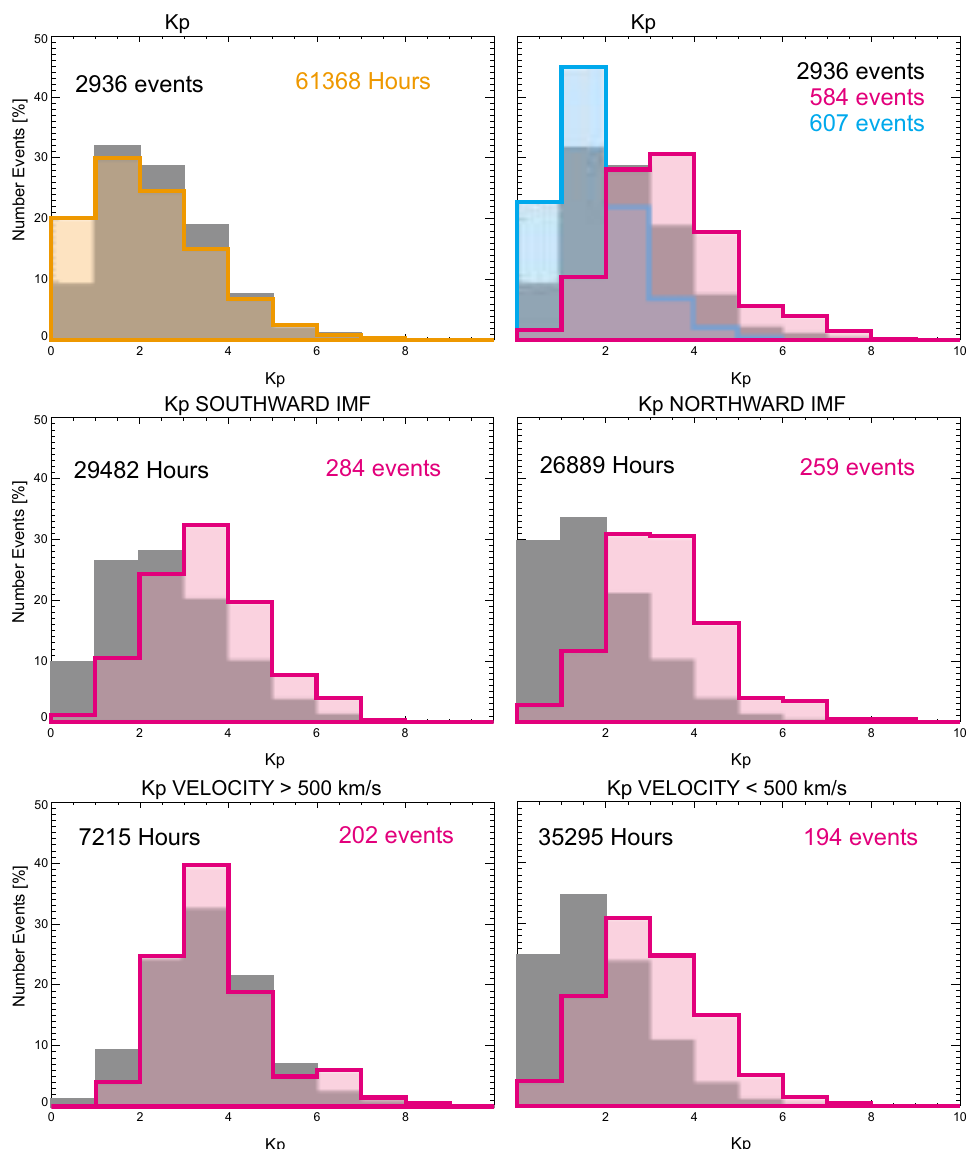
Fig. 14. Relative occurrences as functions of K p at the time of events are displayed. In the top two panels, the gray block diagrams present the distributions for all events. In the top left panel is shown also (orange curve and shading) the background distribution for the entire period covered in the analysis (61368h). The panel at the top right displays the separate distributions for the large (magenta) and small (cyan) amplitude subgroups of events. The middle panels display the background distributions (gray block-diagrams) as well as the large amplitude events (magenta curves and shading) for southward (left panel) and northward (right panel) IMF conditions, respectively. Similarly, the bottom panels show the separate distributions for solar wind speeds larger (left panel) and smaller (right panel) than 500 km/s,